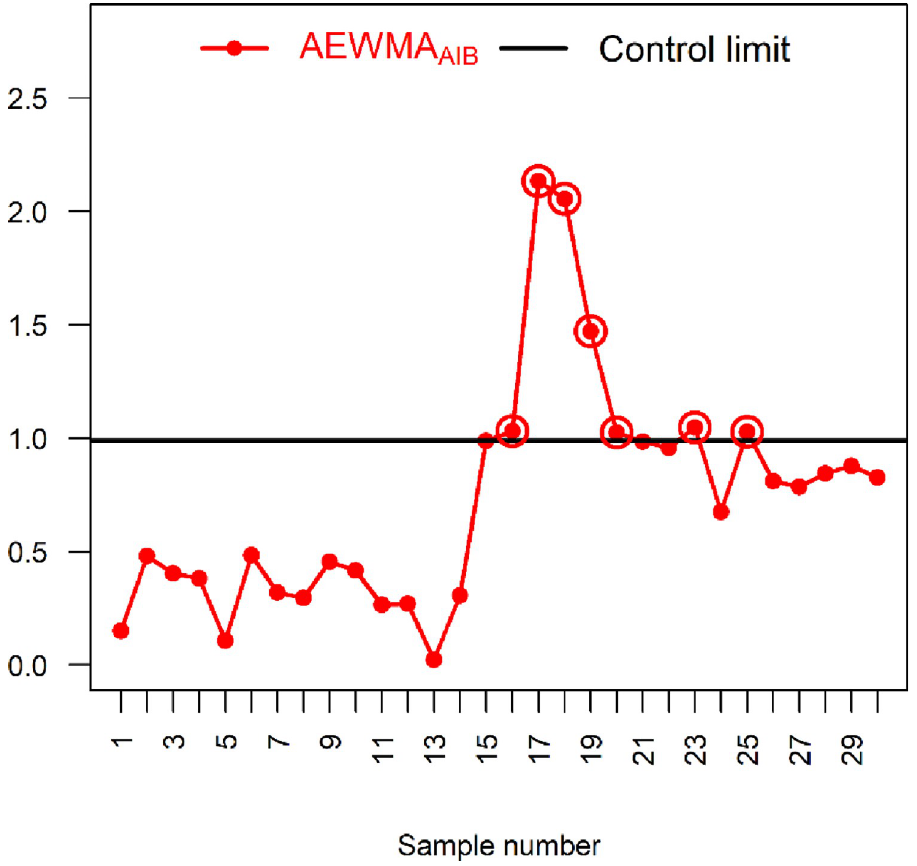
¼ 0 : 9879 and ARL 0 AEWMA AIB